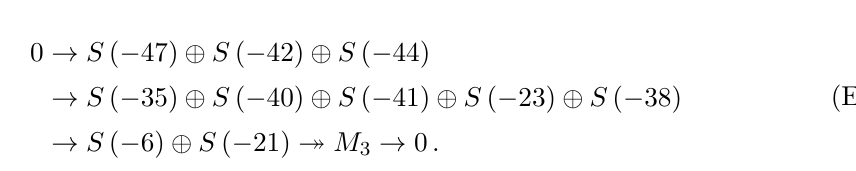
(cid:17) (cid:17) and dim Q 0